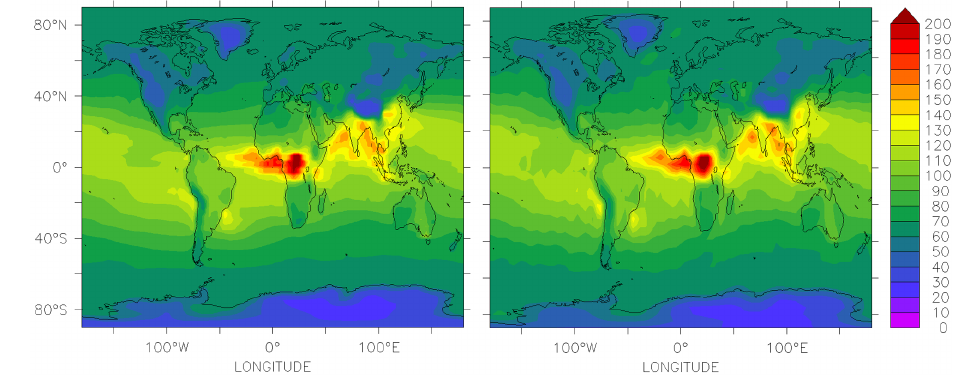
Figure 3. Column resistance (P (cid:127) m 2 ) for January from the maCMAC-FV (left) and maEMAC (right) simulations.